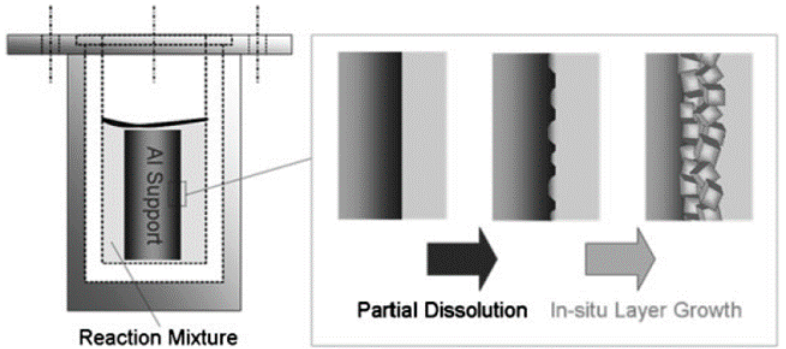
Figure 5. Direct crystallization by hydrothermal synthesis. Schematization of the process with detail about the partial support transformation (PST) method [40]. (Copyright from John Wiley and Sons